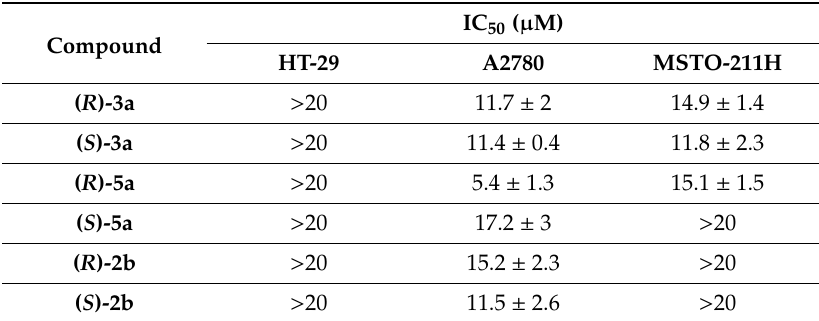
Table 3. Antiproliferative activity of compounds 3a , 5a , and 2b in chiral